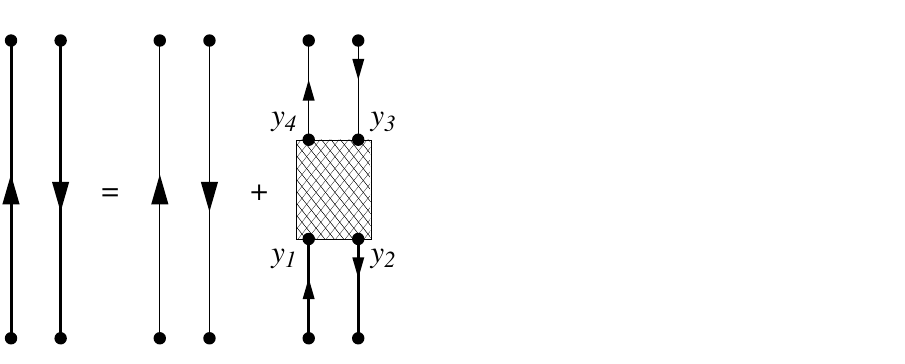
Figure 3. Graphical representation of Equation (110). The criss-cross box represents the proper kernel ˆ (cid:75)